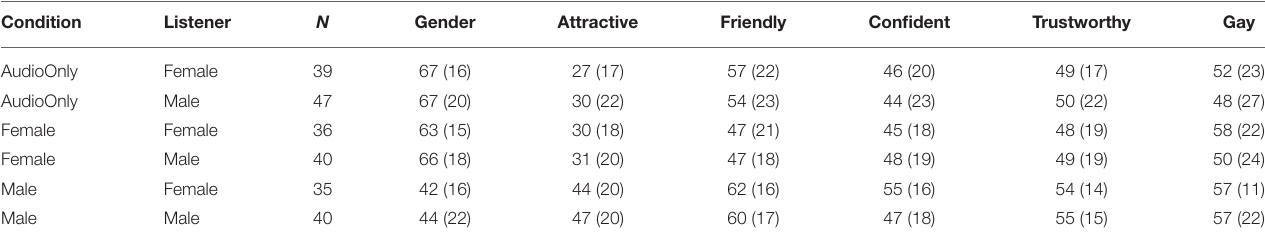
TABLE 1 | Mean ratings (and standard deviations in parentheses) for perceived vocal gender, attractiveness, friendliness, confidence, trustworthiness, and gayness in the two face conditions arranged by the gender of the participants.